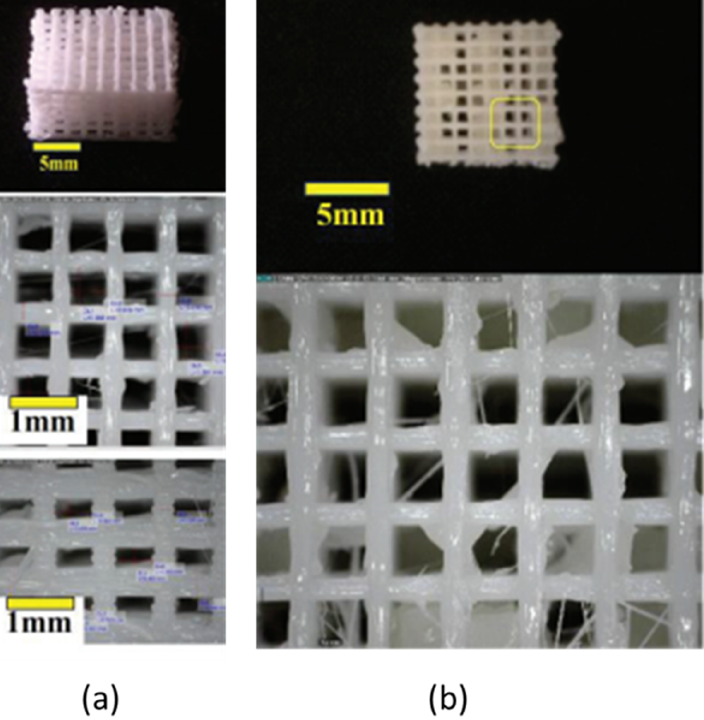
Figure 1. ( a ) Six-layer 3D PLA scaffold; ( b ) post hydroxyapatite (HA)/alginate composite injection to six-layer 3D PLA scaffold.